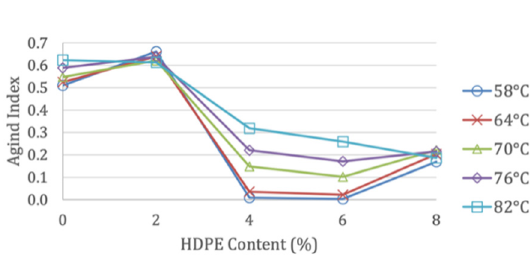
Figure 6. Aging index vs. HDPE content.